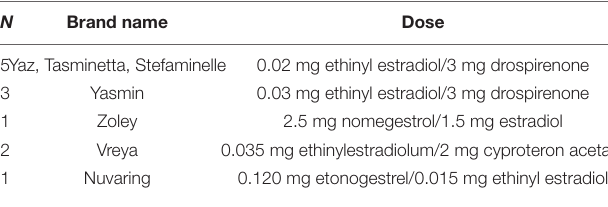
TABLE 2 | Brand and dosage of hormonal contraceptives used by participants in the monophasic hormonal contraceptive user group